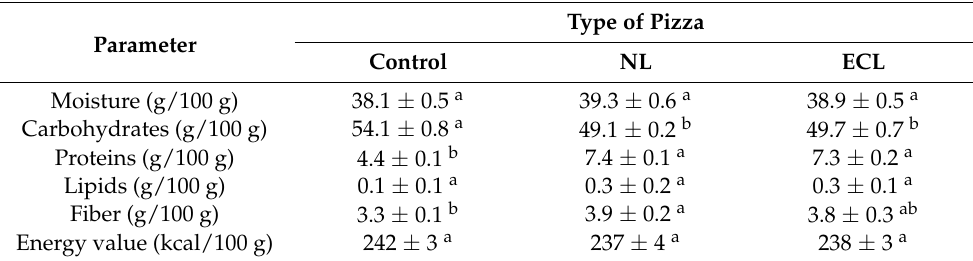
Table 4. Nutritional composition and energy value of the experimental GF pizza samples. NL = native lentil flour; ECL = extruded-cooked lentil